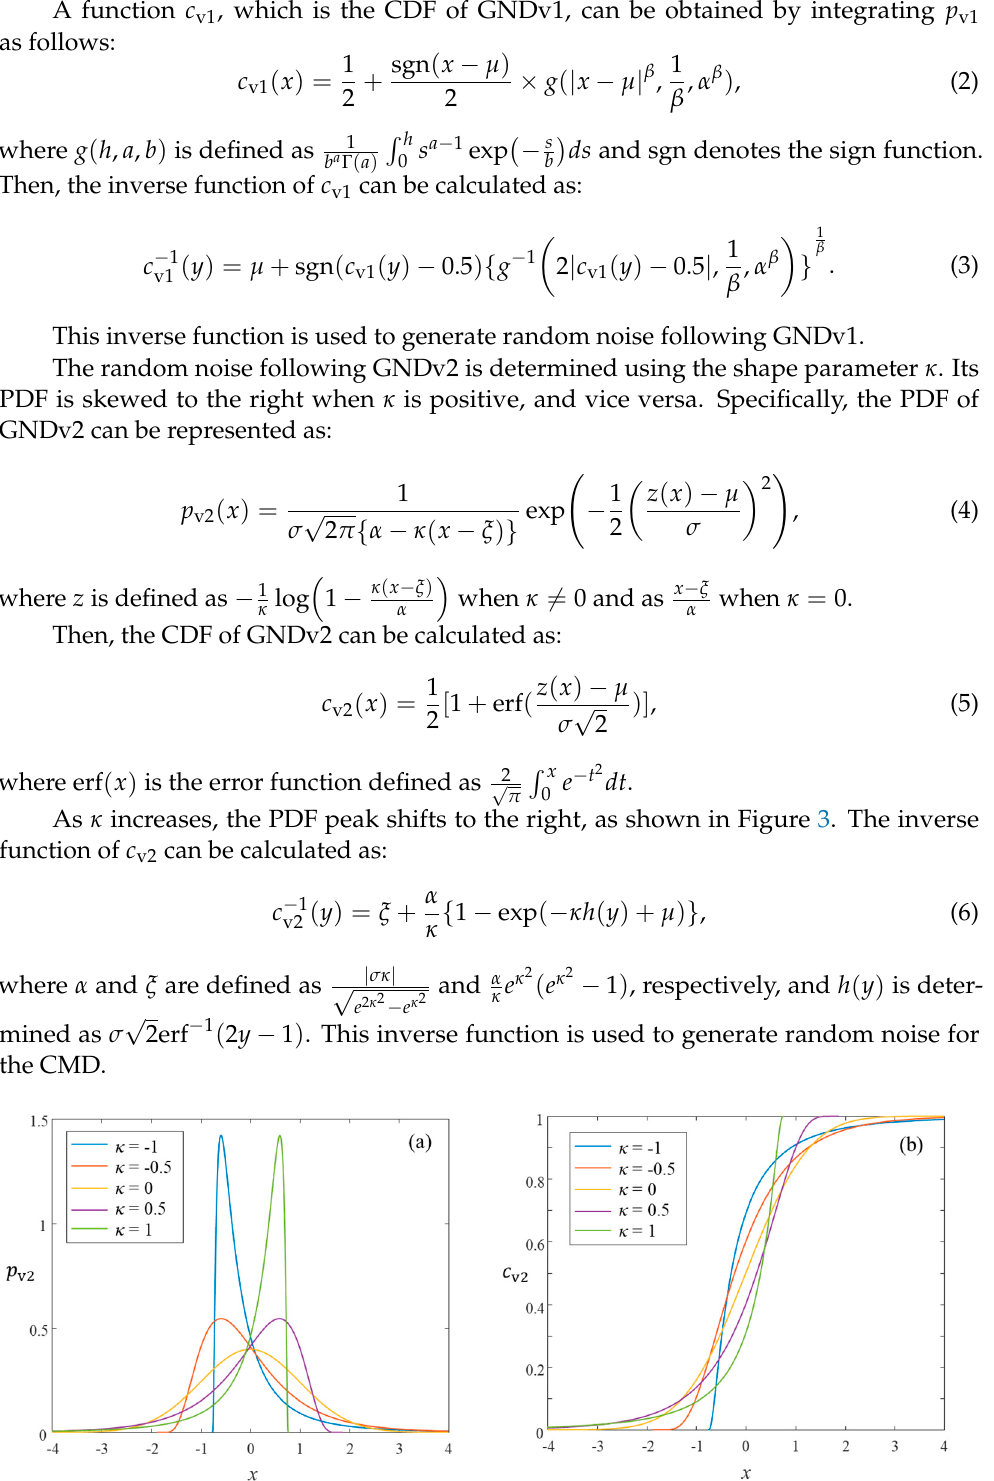
Figure 3. ( a ) Probability and ( b ) cumulative distributions for GNDv2 with zero mean and unit standard deviation.